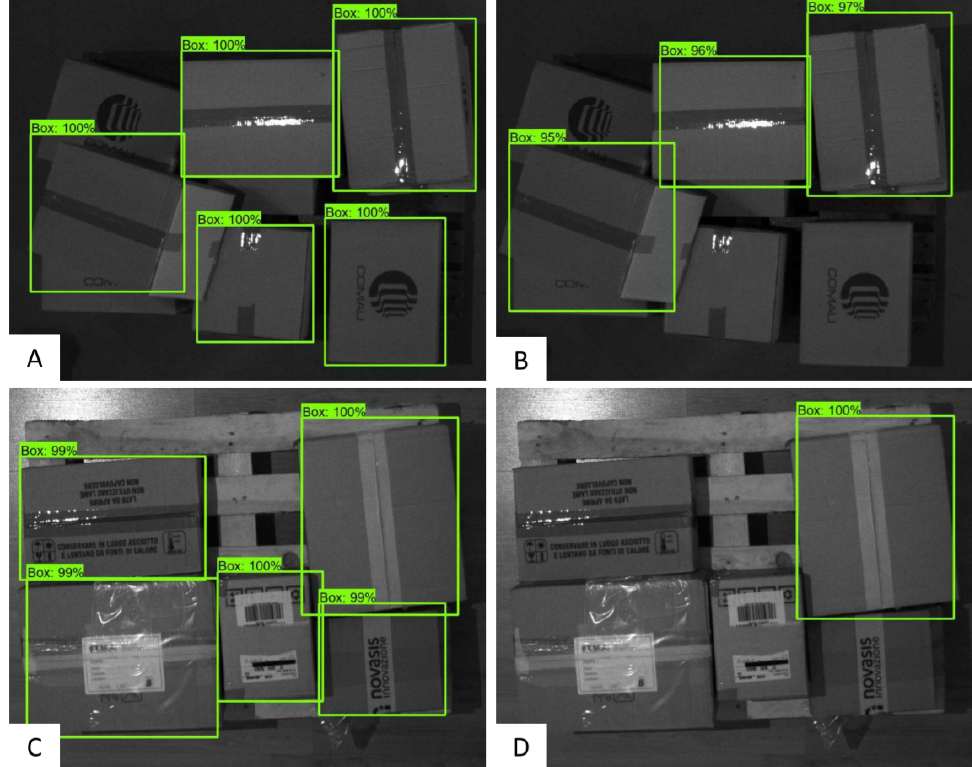
Figure 7. ( A ) Sample result of the model fine-tuned on Dataset 1 considering Case 3b. ( B ) Sample result of the model fine-tuned on Dataset 1 considering Case 2a. ( C ) Sample result of the model fine-tuned on Dataset 2 considering Case 3b. ( D ) Sample result of the model fine-tuned on Dataset 2 considering Case